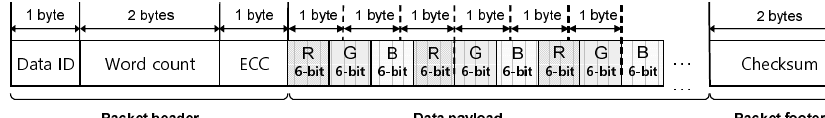
Figure 2. A packed-pixel stream of the 18-bit RGB format